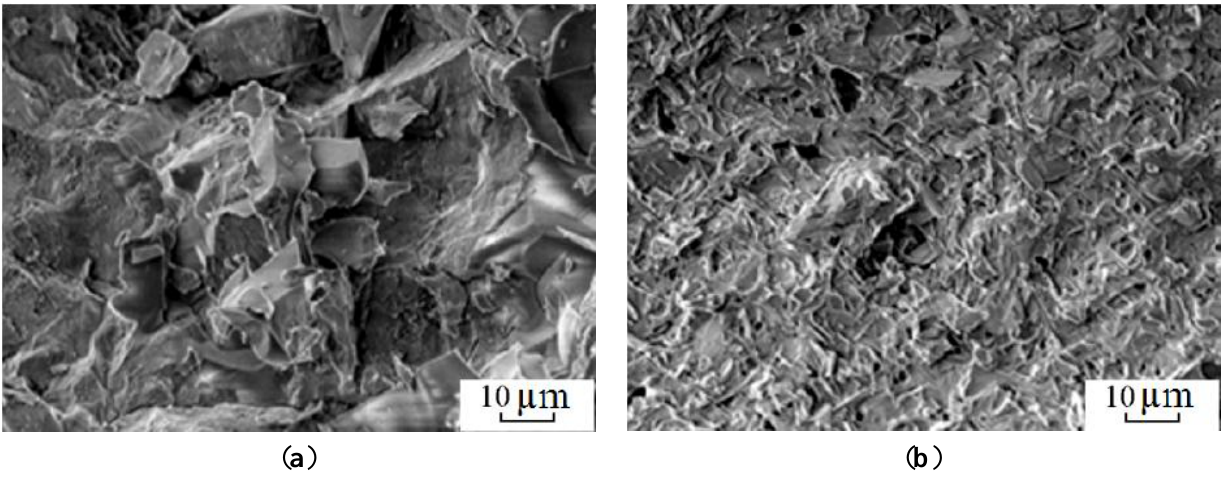
Figure 44. Fracture surface of the samples sintered from the MgO-Al sample 1 ( a ) and sample 2 ( b